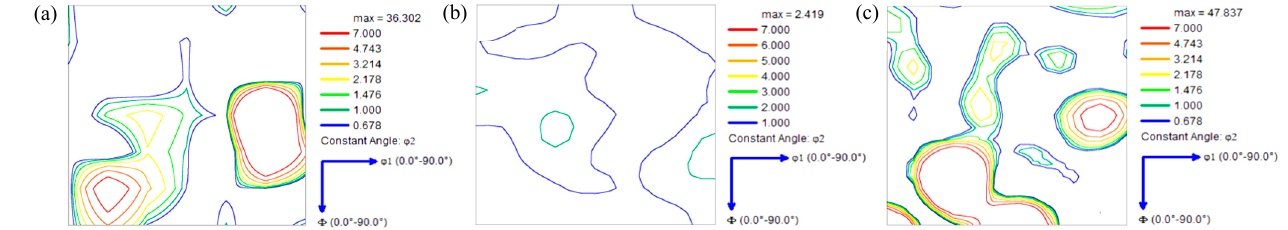
Figure 8. Constant ϕ 2 = 45 ◦ ODF sections of E36 ( a ), EH36 ( b ) and FH36 ( c ) steel plates. Figure 8. Constant φ 2 = 45° ODF sections of E36 ( a ), EH36 ( b ) and FH36 ( c ) steel plates.